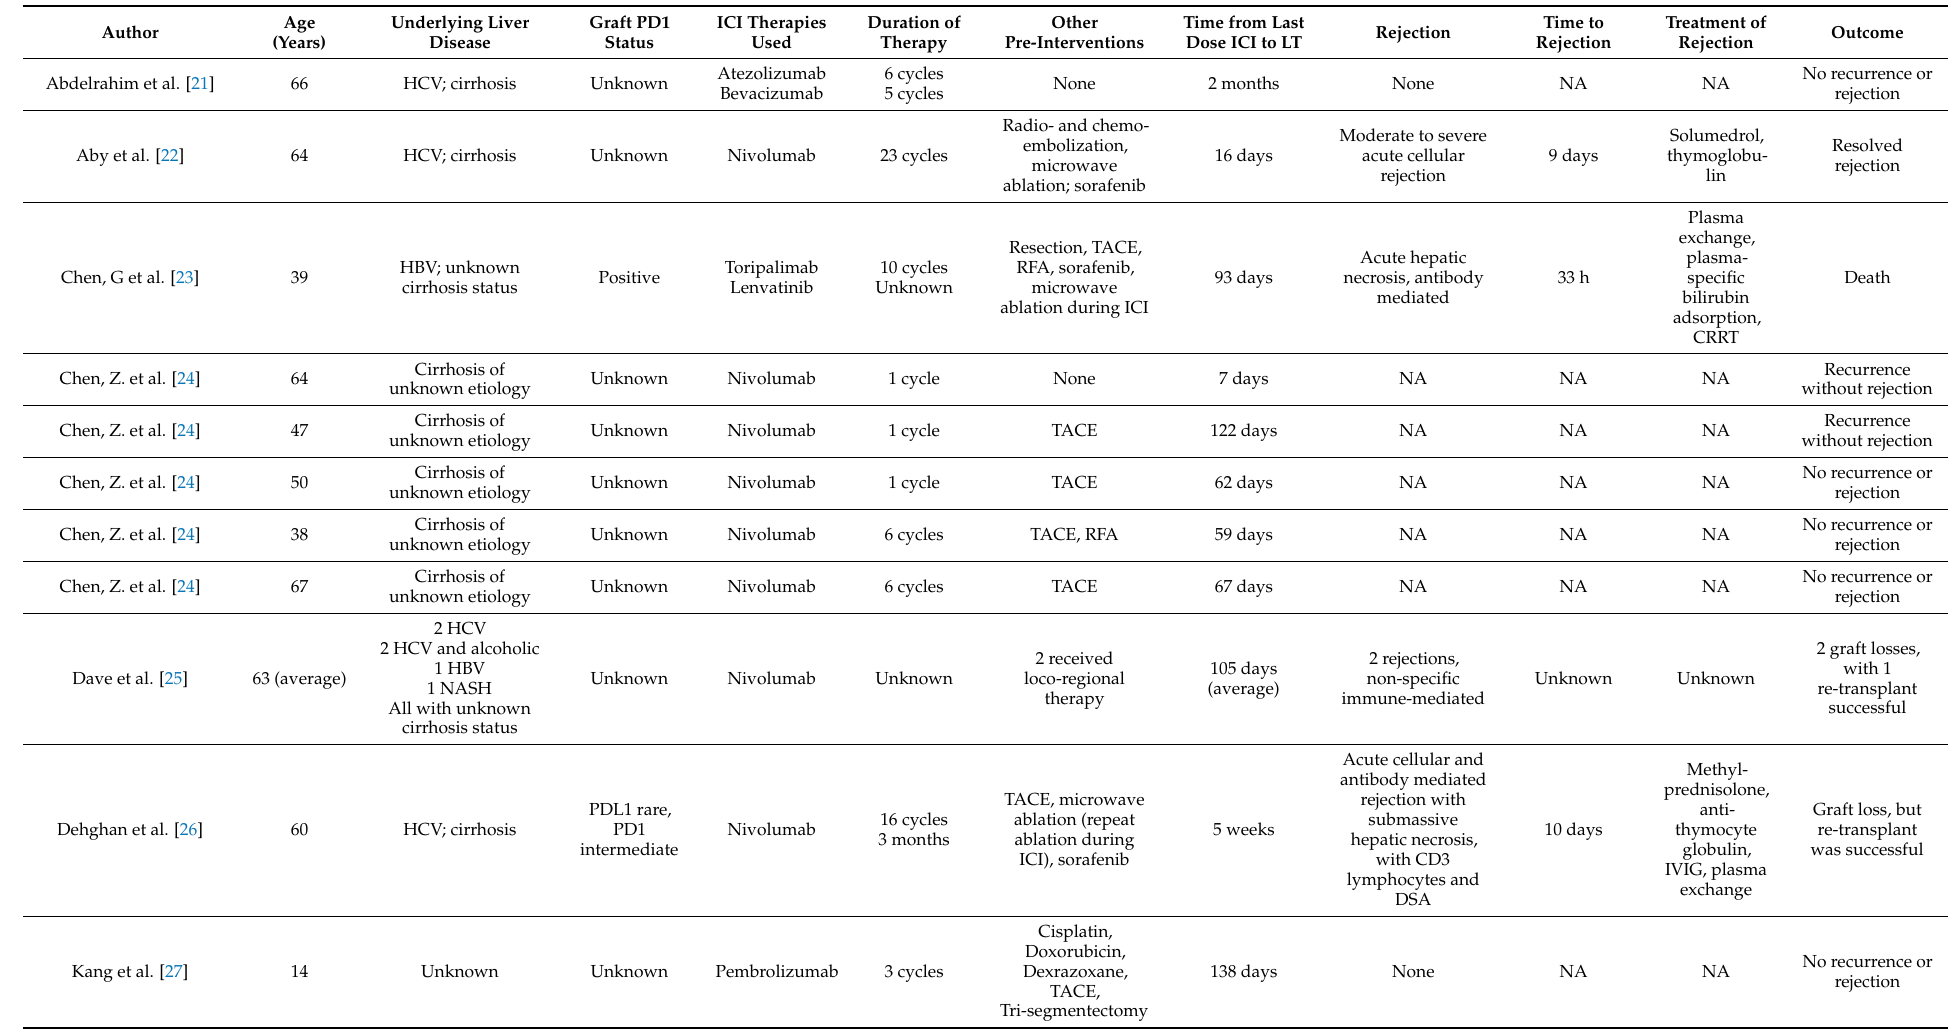
Table 2. Cases of immune checkpoint inhibitors use in the pre-liver transplant